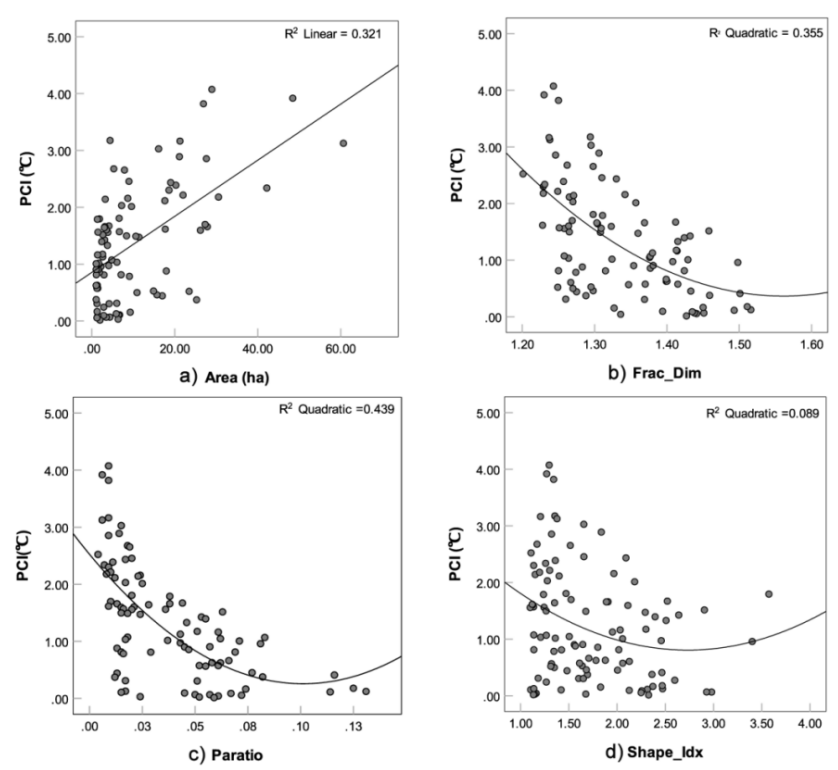
Figure 6. Regression analysis among PCI and mean park characteristics: ( a ) Size; ( b ) Frac_Dim; ( c ) Paratio; ( d ) Shape_Indix.